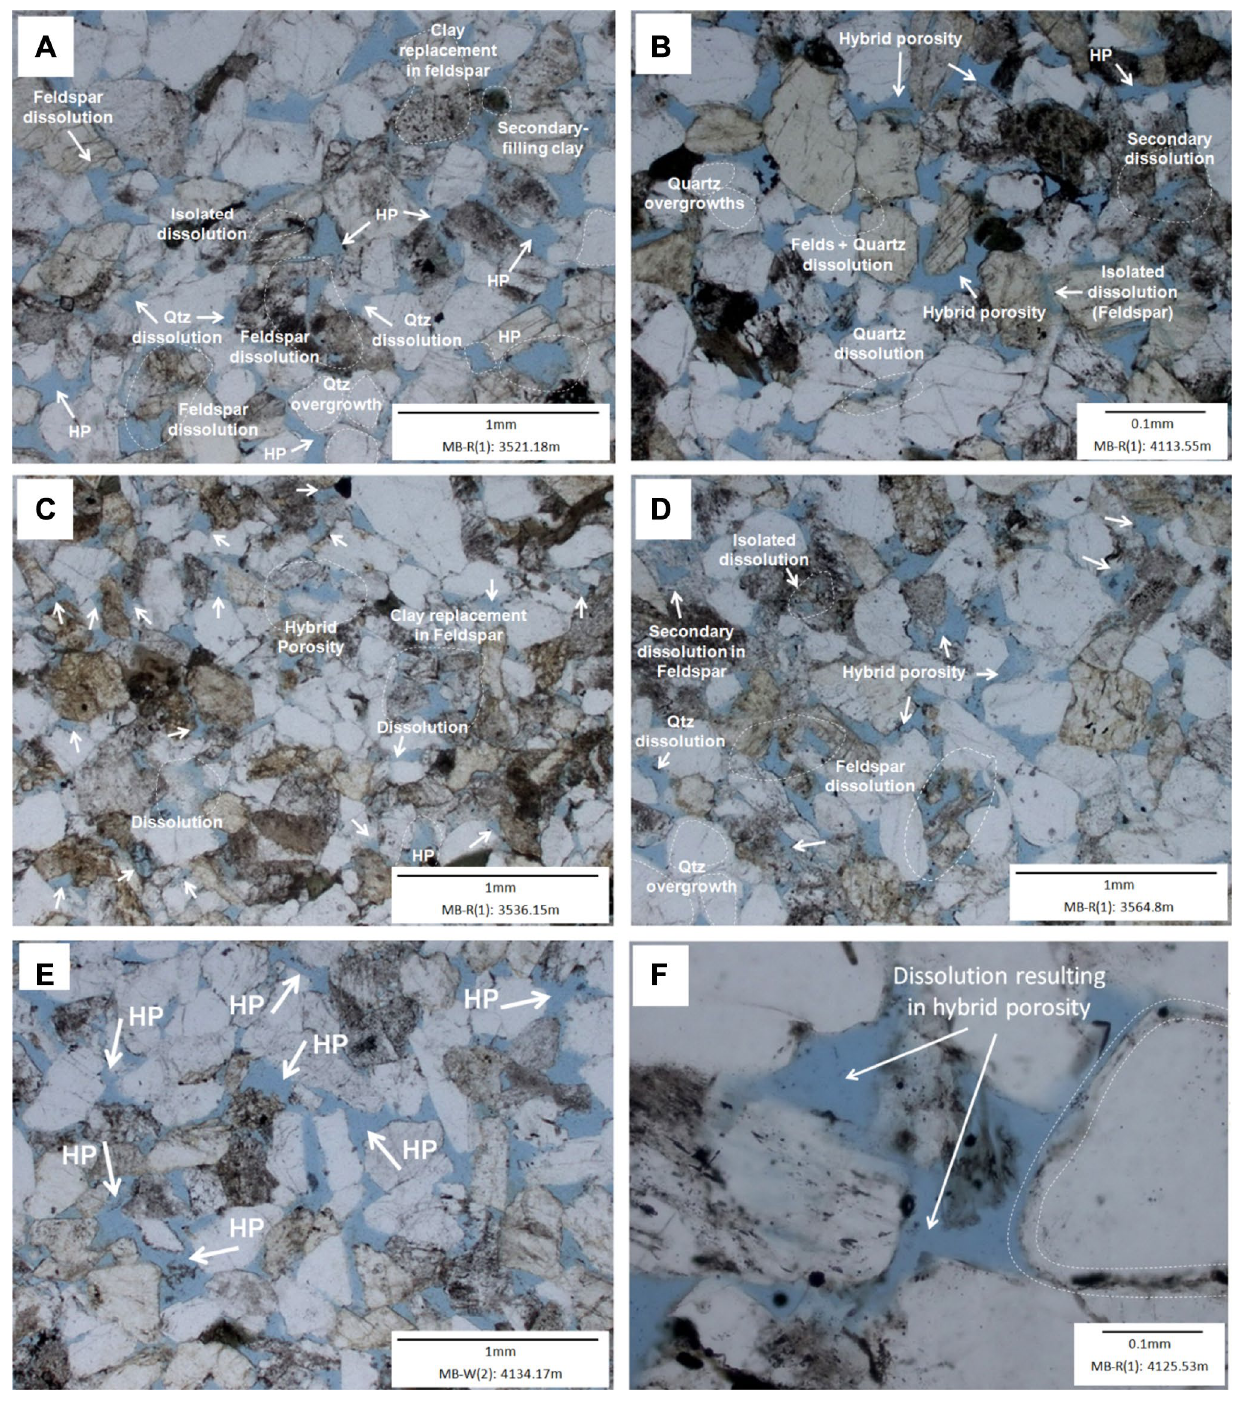
Fig. 7 Features observed in the selected Farewell Formation sample data: a – d primary intergranular porosity (stained blue), secondary dissolution in feldspar and quartz and hybrid porosity, with quartz